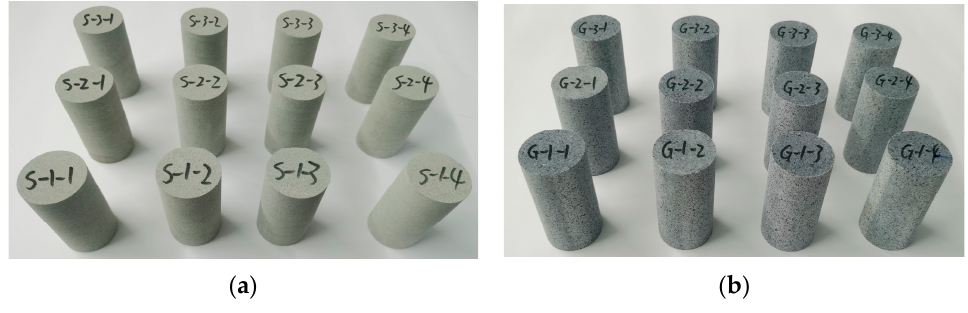
Figure 1. Rock specimens. ( a ) Sandstone; ( b ) granite.